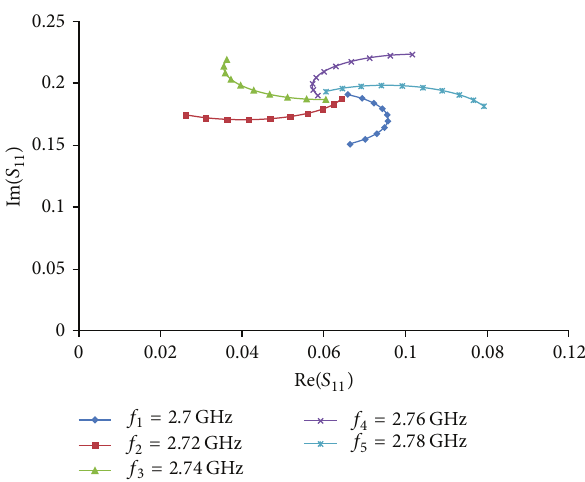
Figure 13: 𝑆 11 at the input port of the antenna in the complex plane for 5 different frequencies.